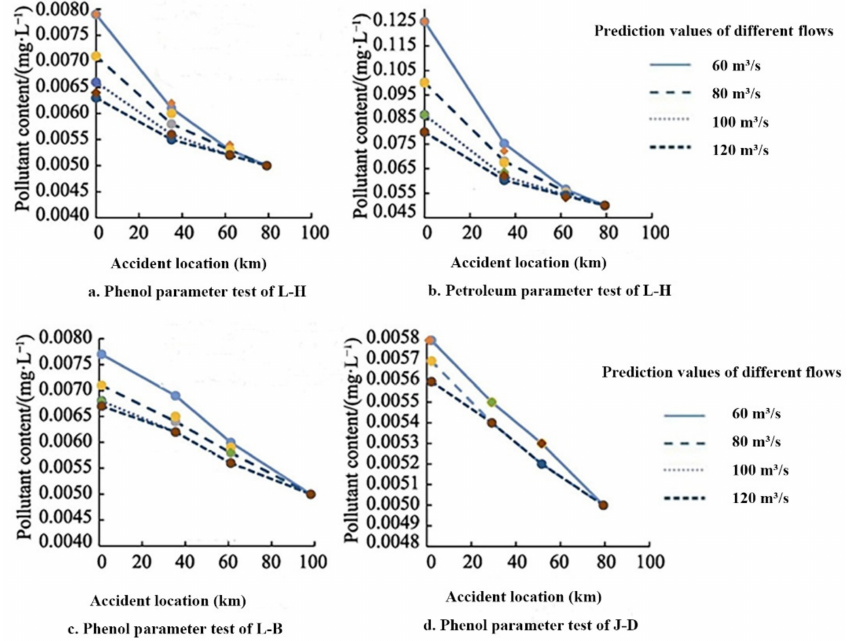
Figure 2. The pollutants’ concentration change process under different conditions.